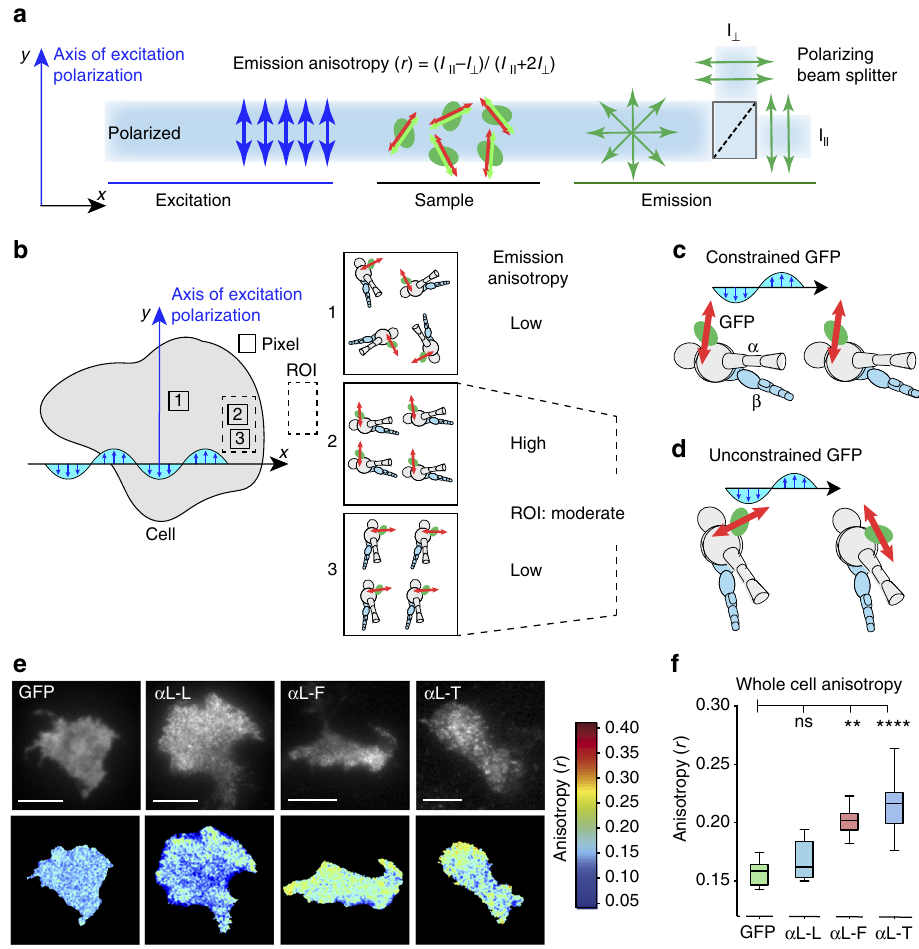
Fig. 2 Emission anisotropy of GFP-LFA-1 fusions. a Schematic of emission anisotropy TIRF microscopy 27 . The transition dipole of GFP has an excitation dipole (green) that is very close in orientation to its emission dipole (red) 28,29 . I II and I ⊥ are emission intensities parallel and perpendicular to the direction of polarized excitation. b – d Schematics showing a cell and integrins in same microscope xy plane as in a and different outcomes in emission anisotropy. The excitation (electric) fi eld of polarized light is shown as a blue wave. b . Outcomes using a constrained integrin-GFP fusion. Depending on the orientation of integrins within pixels (1 – 3) or regions of interest (ROI), the emission anisotropy will change as indicated. c , d Outcomes with aligned integrins with constrained c or unconstrained GFP d . e Representative images from movies of Jurkat T cells stably expressing GFP-LFA-1 fusions migrating on ICAM-1. Each pair of panels (scale bars are 5 µ m) shows total GFP fl uorescence intensity (upper) and anisotropy (lower, color scale to right). f Emission anisotropy of GFP-LFA-1 fusions, averaged over Jurkat T cells migrating in random directions, in at least fi ve independent experiments. Box plots show the full range (whiskers) of observations with median as line and 25 – 75 percentile range boxed. Kruskal – Wallis test with multiple comparison correction gave the indicated P values. N (number of cells) from left was 18, 22, 17, 37. * p < 0.05; ** p < 0.01; **** p <